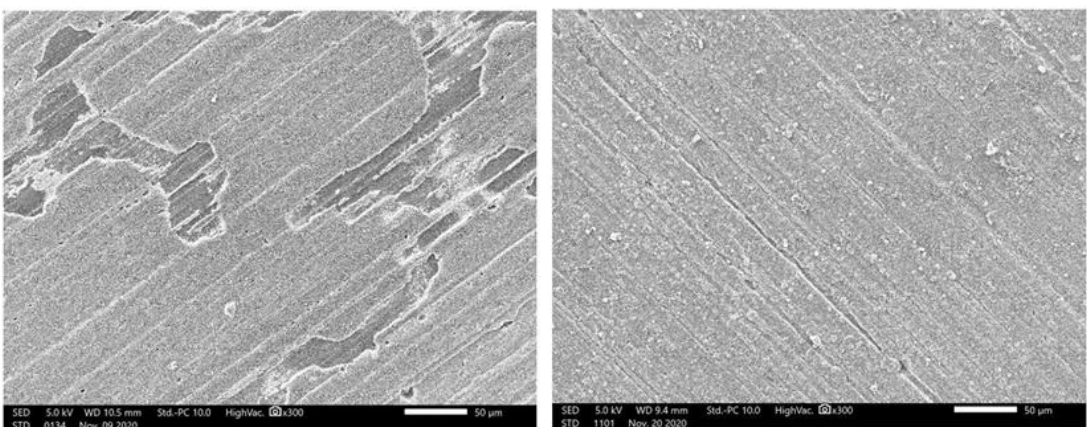
Figure 2. SEM images of ZnO nanorods grown on seed layer deposited by two methods, spray coating and chemical bath deposition.